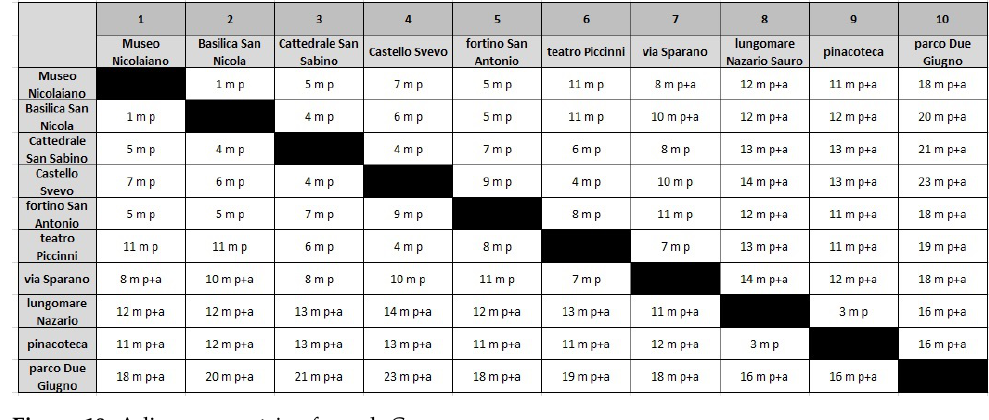
Figure 10. Adjacency matrix of graph G i .